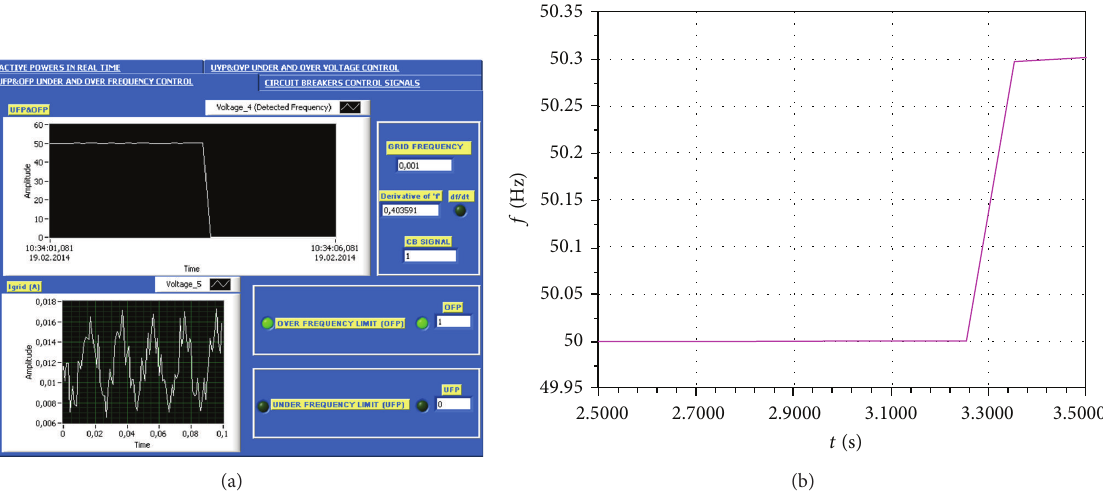
Figure 22: Frequency change of the system in real time (over frequency condition).